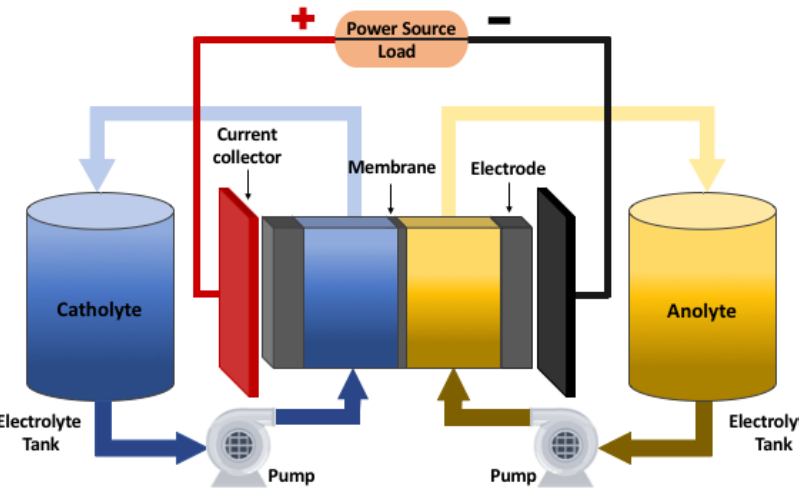
Figure 2. Scheme of a redox flow